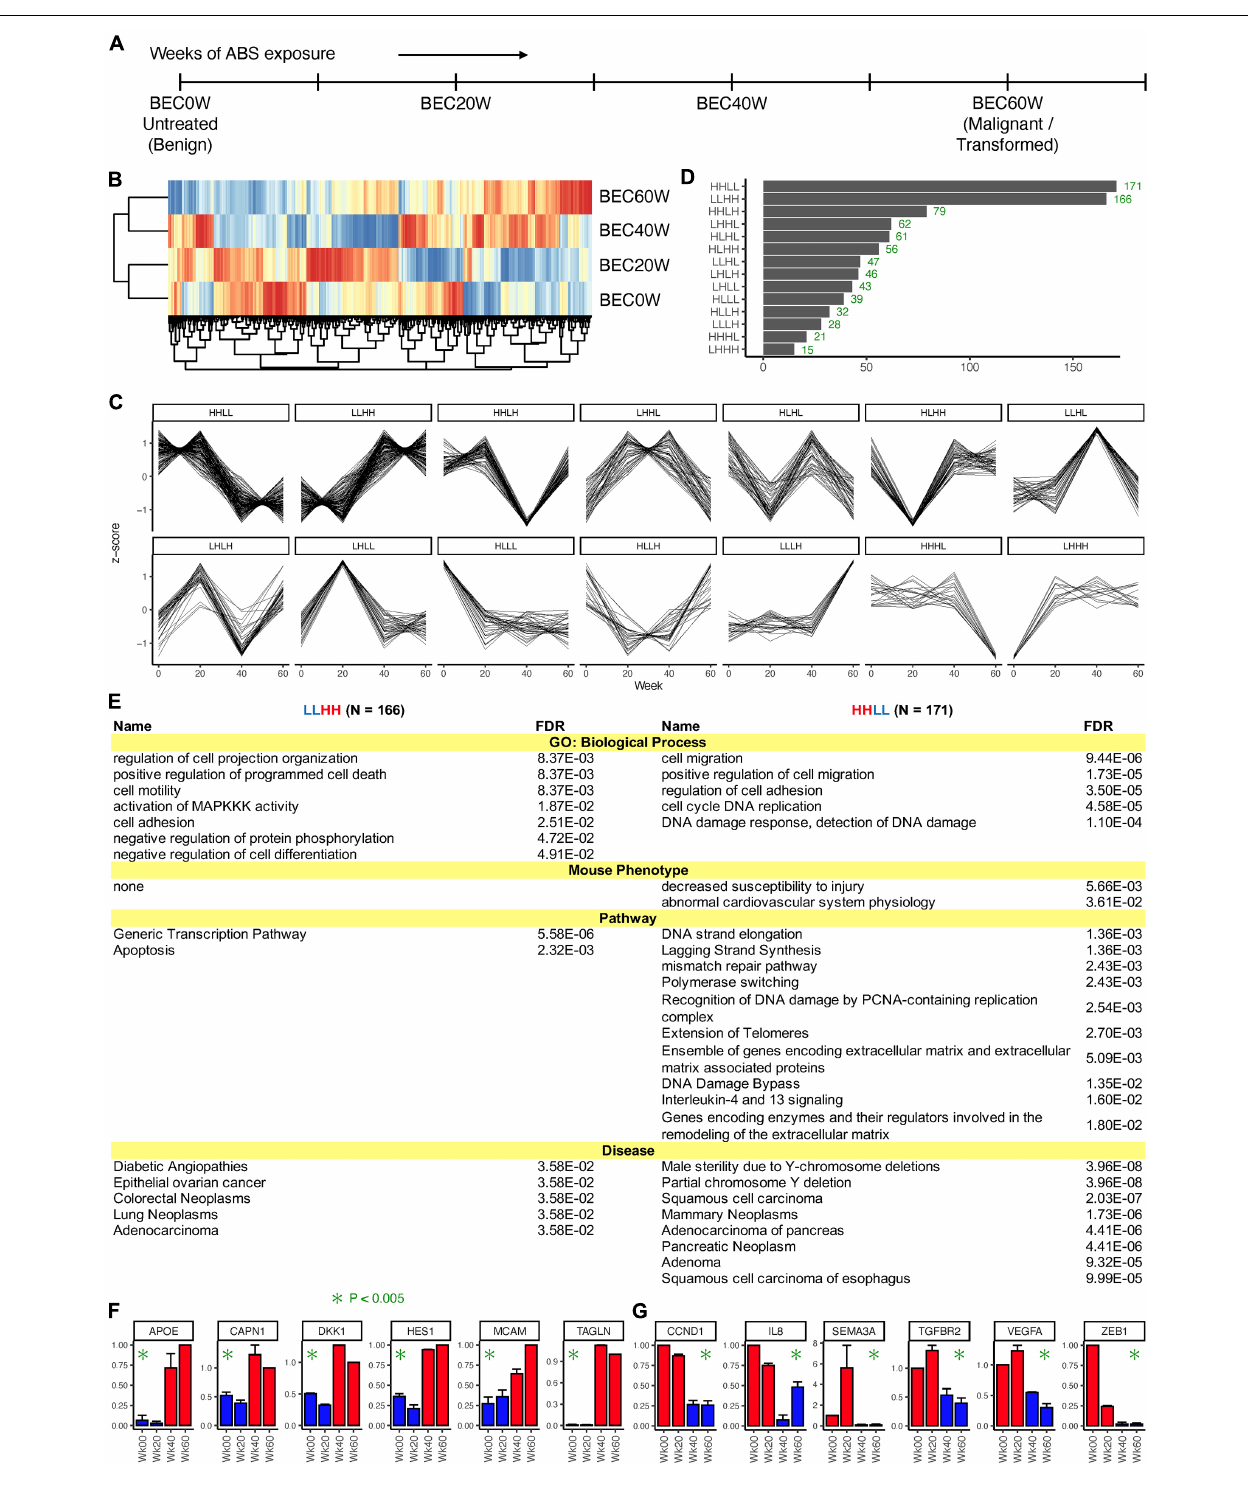
FIGURE 1 | Overall pattern of time series changes in gene expression. (A) The outline of the BEC model and time points selected for transcriptomic analyses. (B) Heatmap (with hierarchical clustering) of the expression data of 866 genes that showed a twofold or higher variation in expression across the four time points. (C) Classification of the genes based on whether the expression at the four time points (BEC0W, BEC20W, BEC40W, and BEC60W) are higher or lower (H/L) than the average of the four time points. (D) Number of genes in each category. (E) Biological processes, mouse phenotypes, pathways, and diseases enriched in the genes of the LLHH (left) and HHLL (right) patterns. (F,G) Confirmatory quantitative PCR for randomly selected genes from LLHH and HHLL